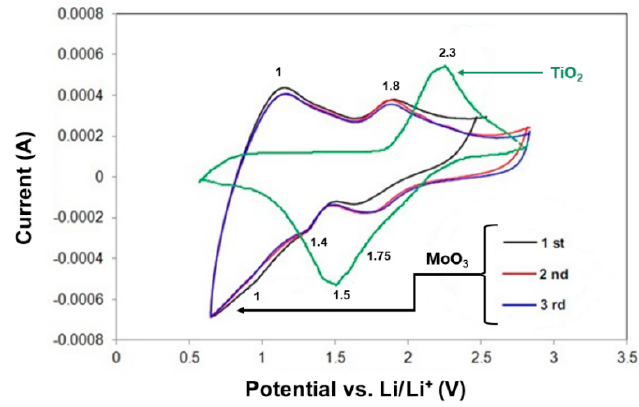
Figure 11. Cyclic voltammograms at a scan rate of 0.5 mV / s for TiO 2 and MoO 3 when not forming a composite system.